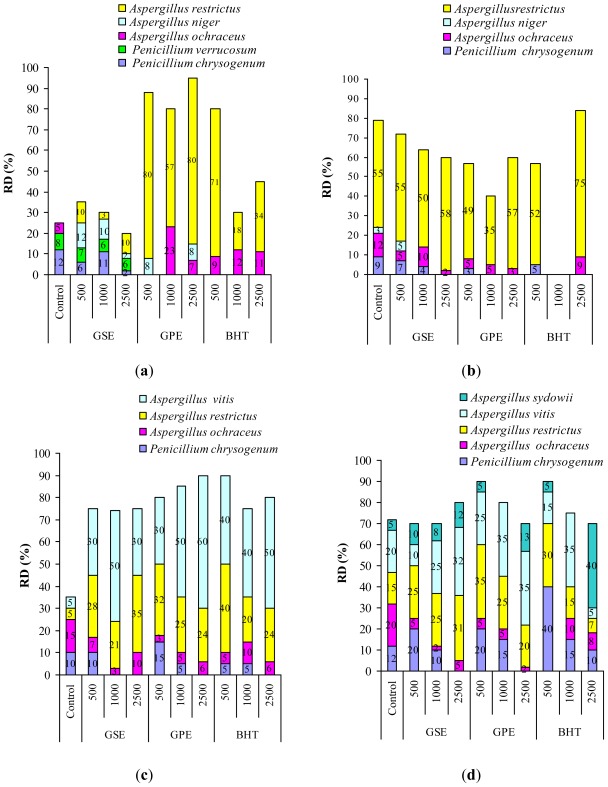
The impact of treatment with GSE, GPE and BHT on RD of fungus species of OTA-producers genera (a) after 7 days; (b) after 14 days; (c) after 21 days; (d) after 28 days.